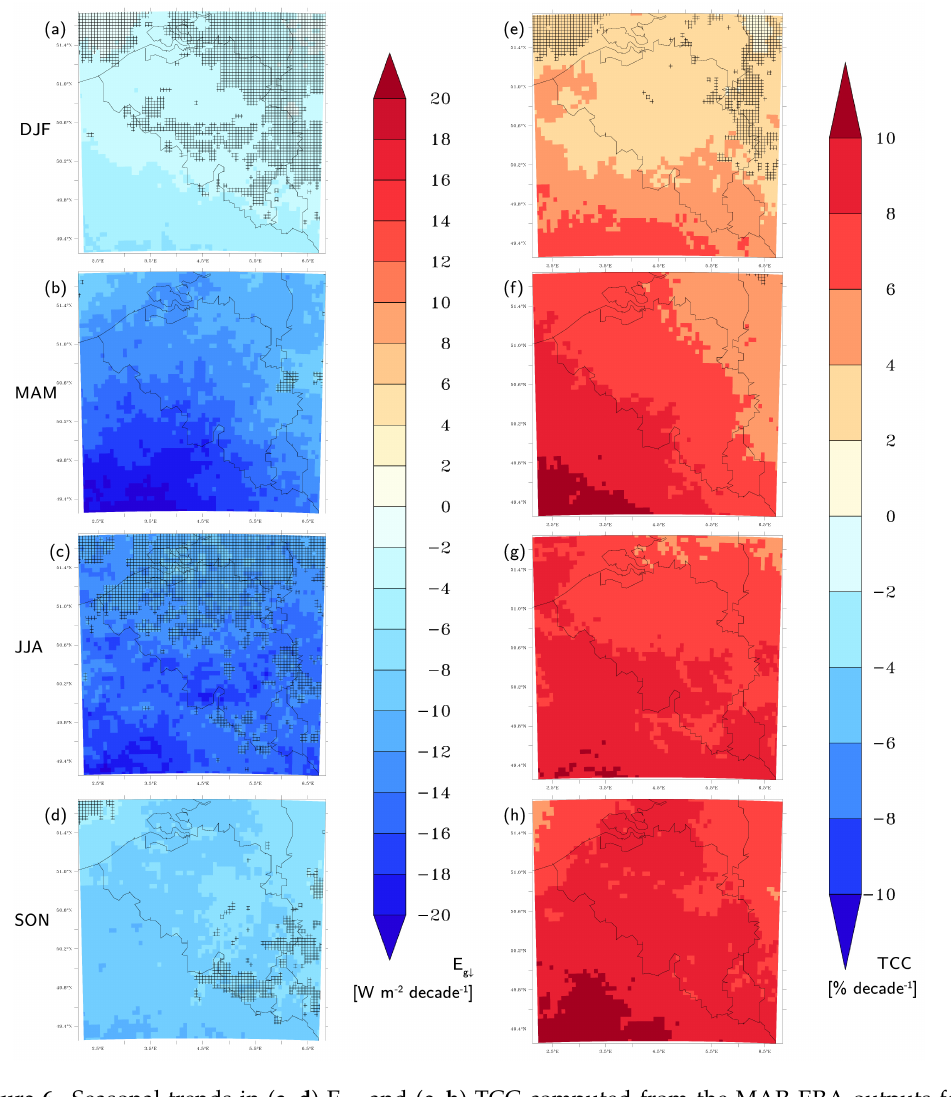
Figure 6. Seasonal trends in ( a – d ) E g ↓ and ( e – h ) TCC computed from the MAR-ERA outputs for 1959–1979 (dimming period) over the study region, as shown in Figure 1. Filled pixels indicate the places where the trends are statistically significant at the 95% confidence level. Hashed pixels indicate the places where the trends are statistically